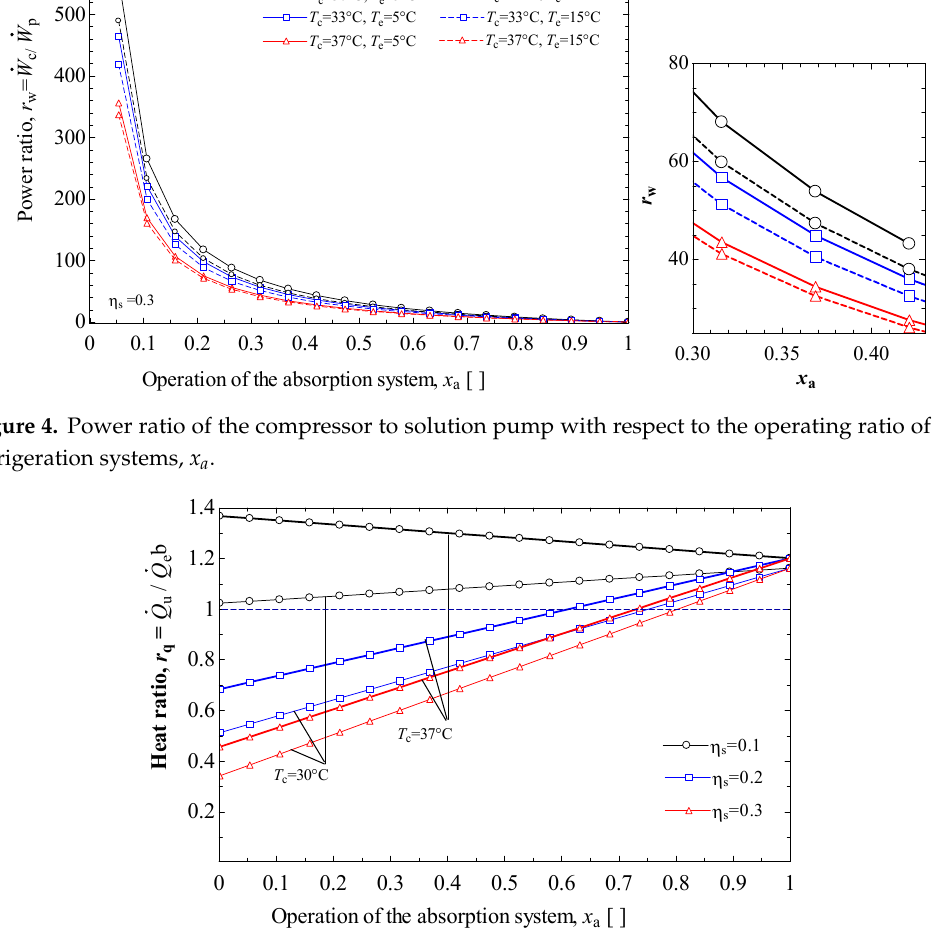
Figure 5. Useful heat to cooling power ratio versus absorption system operating ratio, x a .